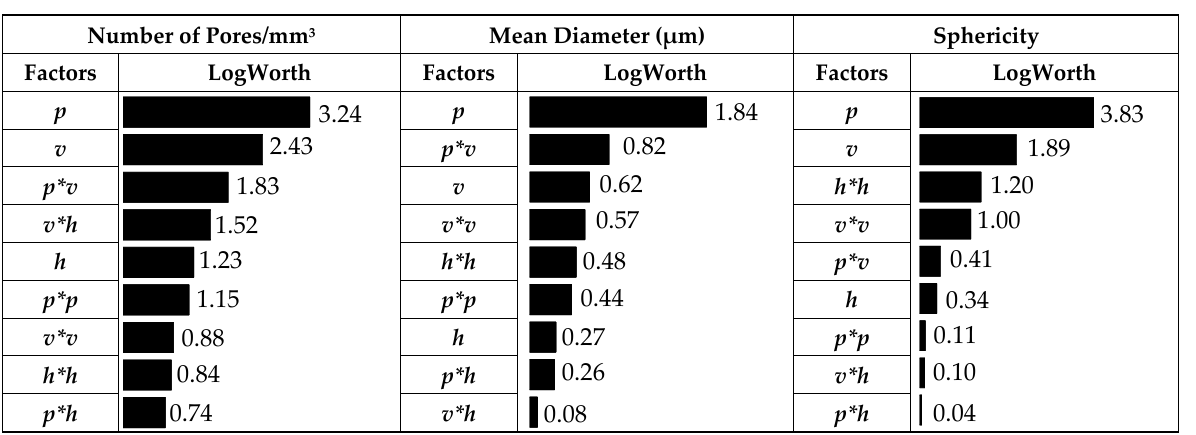
Figure 4. Mathematical modeling of pore properties: ( a ) number of pores/mm 3 , ( b ) mean diameter and ( c ) sphericity. Table 2. Factors and their effects on pore properties based on the regression model of XCT data.